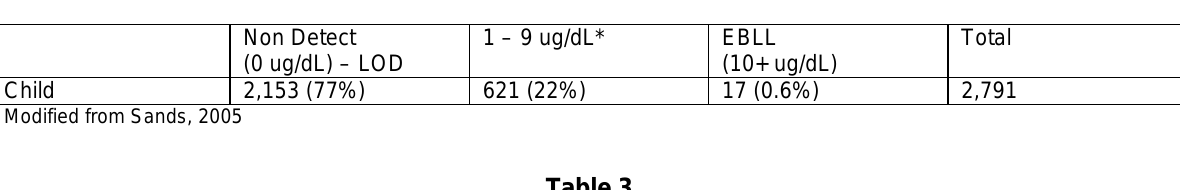
Clark County, NV Blood Lead Levels in Children (August 2004 through August 2005)